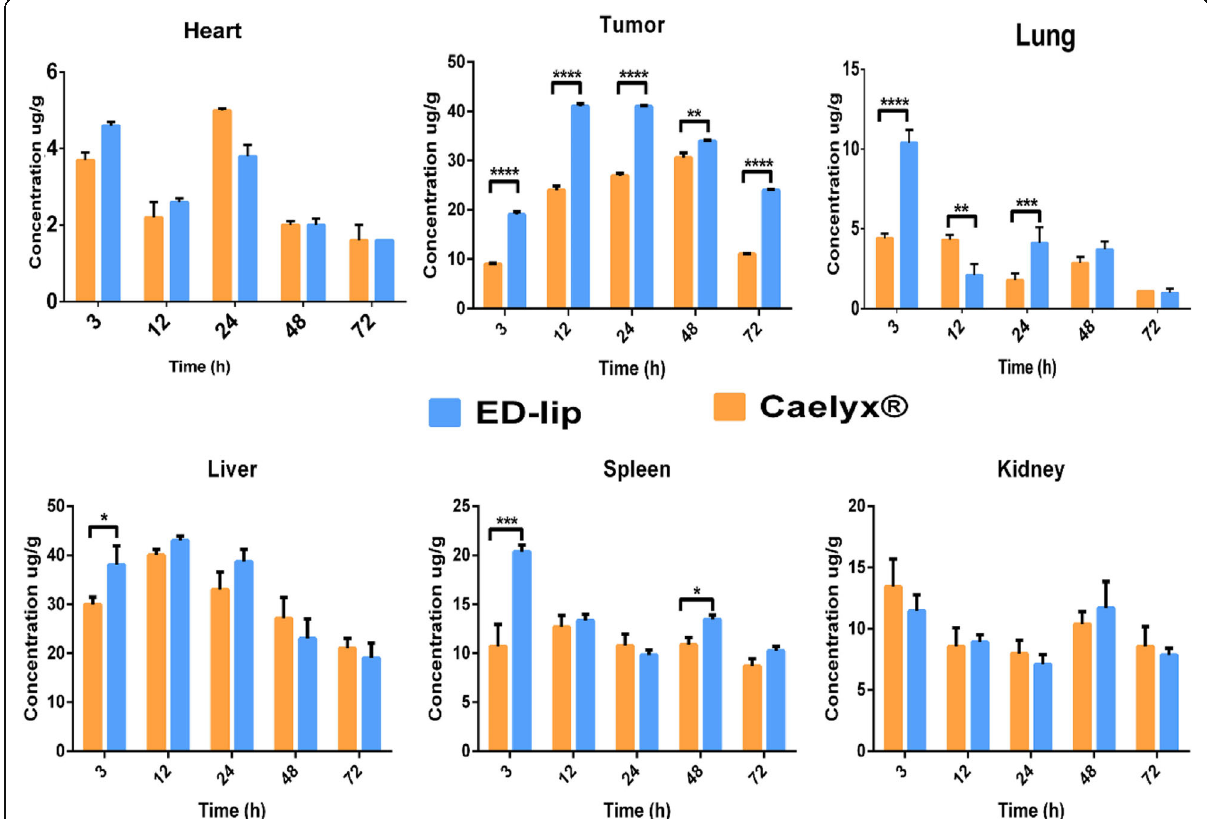
Fig. 8. Tissue biodistribution. The results of DOX biodistribution in heart, tumor, liver, lung spleen, and kidney. The concentrations ( μ g/g) reported at 3, 12, 24, 48, and 72 h post-injection for each organ. Data represented as mean ± standard deviation (SEM) ( n = 3). * p < 0.05, ** p < 0.01, *** p < 0.001, **** p <